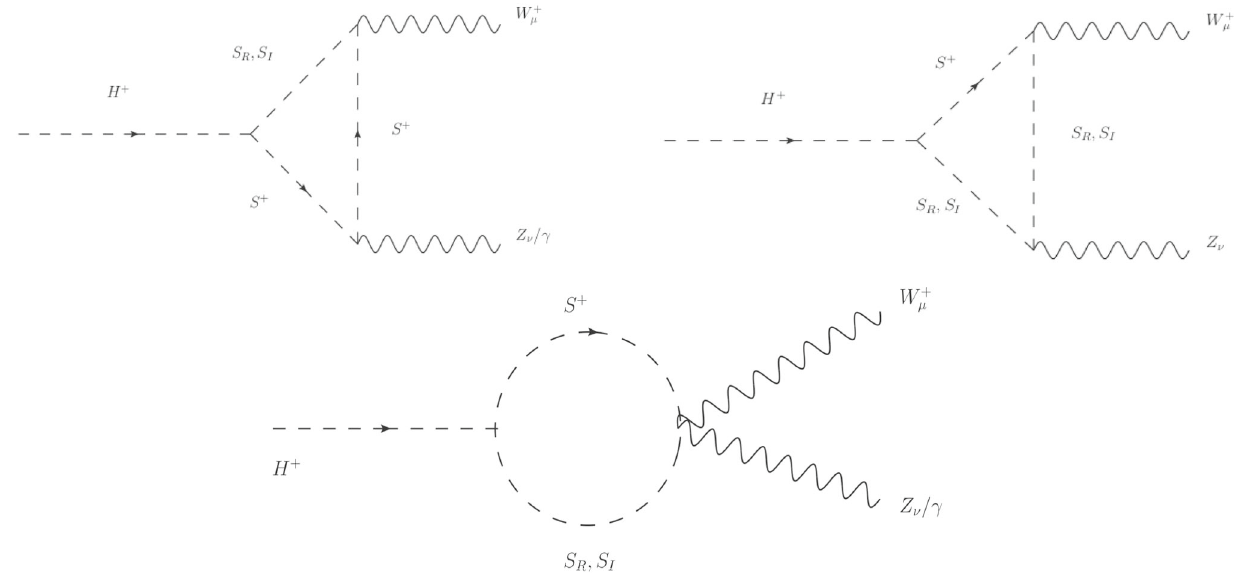
Fig. 1 Set A of one-loop amplitudes